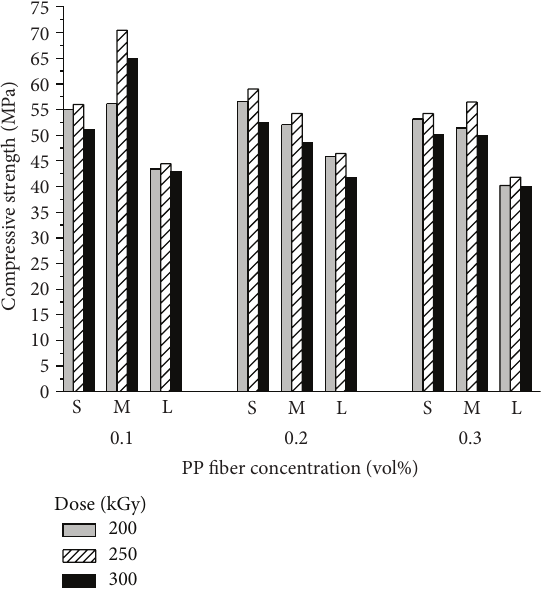
Figure 2: Compressive strength of irradiated-polymer concrete with different marble particle sizes and fiber